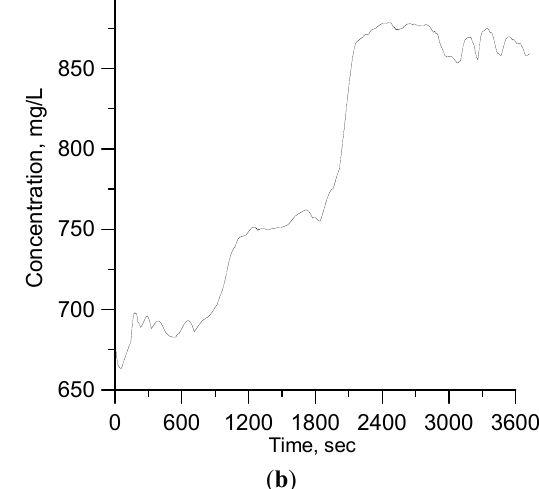
Figure 10. The temporal evolution of the maximum mineralization of the withdrawn water in the presence of bottom barriers for the flow rate of water withdrawn through a single intake head: 2 m 3 /s ( a ), and 4 m 3 /s ( b ) at the velocity of the river flow varying from 0 m/s to 0.1 m/s within 1 h.